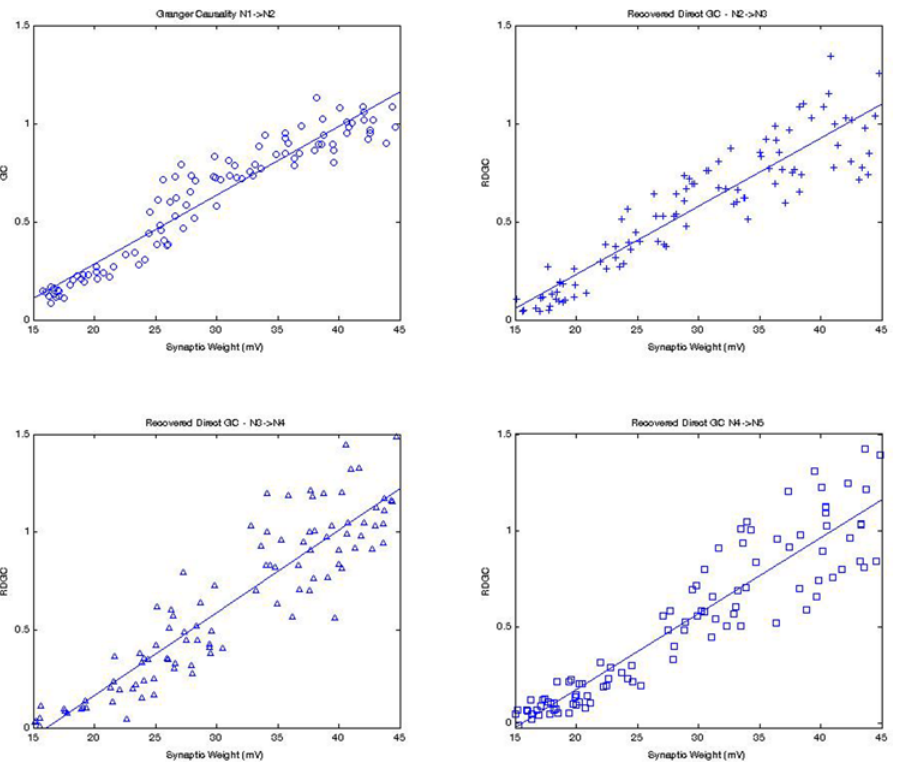
Figure 7. DGC values can be recovered at each of the synapses in the serial chain. Random synaptic weights of 15 mV and 45 mV were generated between each neuron in a five-neuron serial chain and 100 realizations of this chain were created for analysis. These plots demonstrate that DGC values recovered from entangled pathways (top right, bottom right, and bottom left) along the serial chain mirror those calculated using PGC on the first pathway (top left). This suggests that DGC values represent the direct influence between two neurons similar to the PGC relationship that can be calculated between neurons that are not entangled by mediated influences.